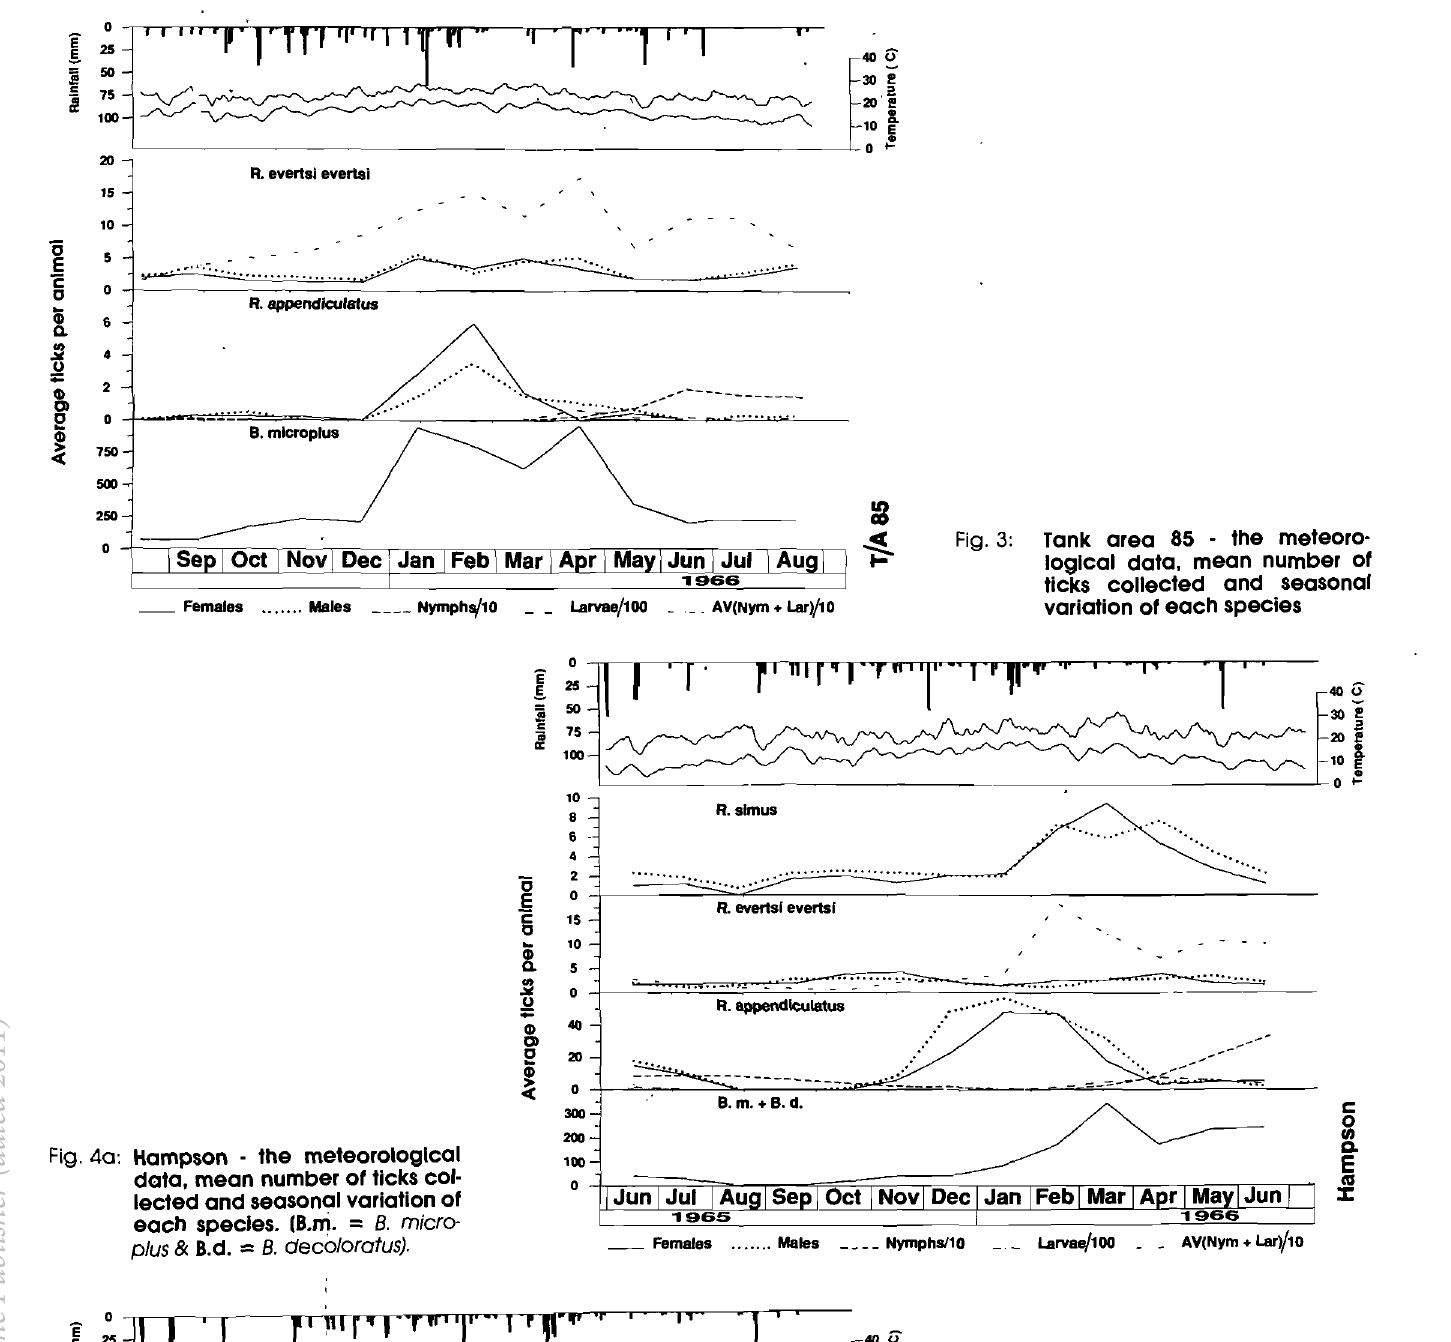
Fig. 40: Hampson - the meteorological data, mean number of ticks col lected and seasonal variation of = each species. (B.m. B. micro' = plus & B.d. B. decoloratus).